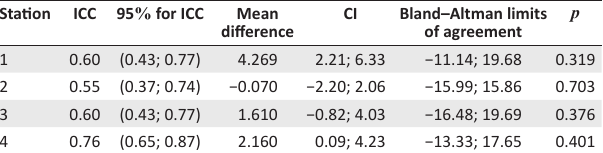
TABLE 1: Intra-station reliability (Readings 1 and 2). Station ICC 95 % for ICC Mean difference